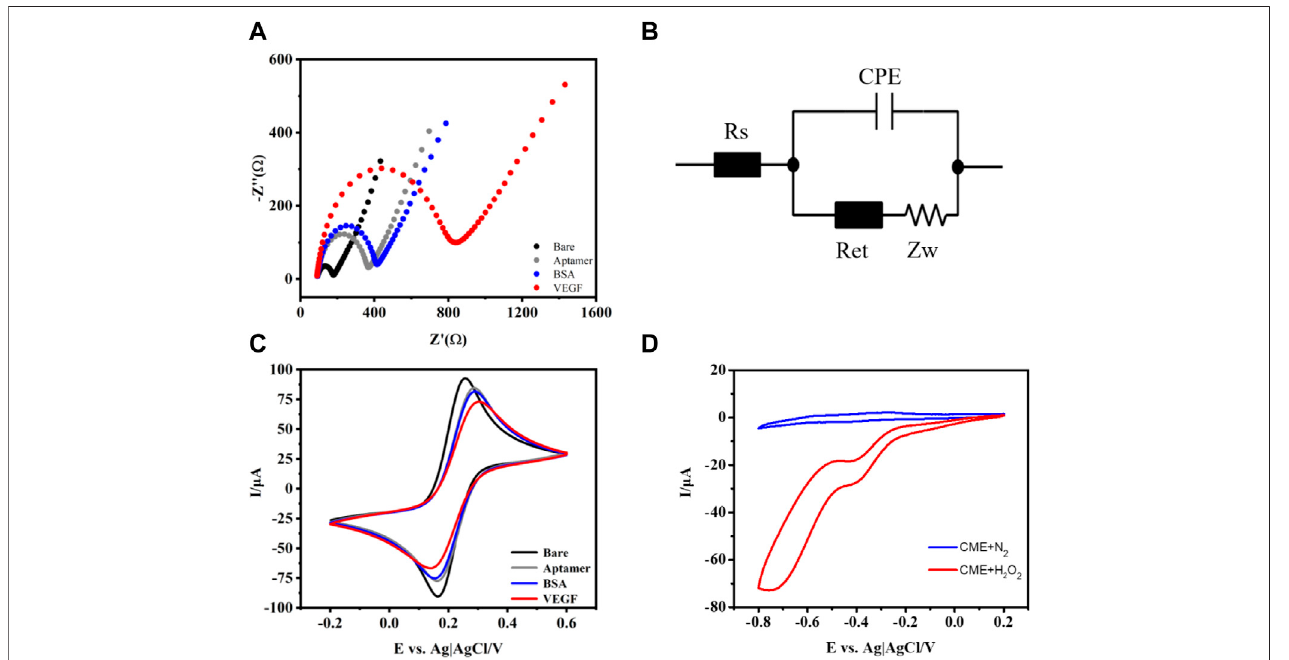
FIGURE 2 | Nyquist plots of the EIS (A) , equivalent circuit diagram (B) , CV for different modi fi ed electrodes (C) , and in PBS buffer with or without H 2 O 2 (D) \ \